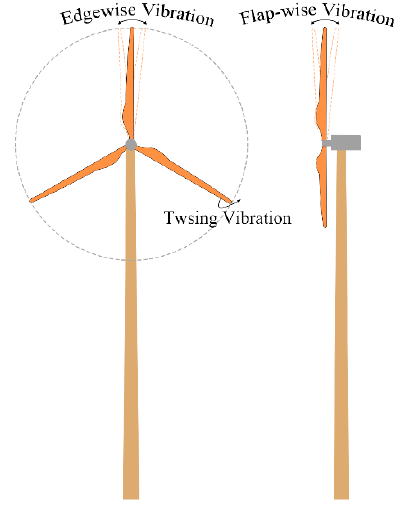
Figure 19. Basic vibration forms of wind turbine blades.